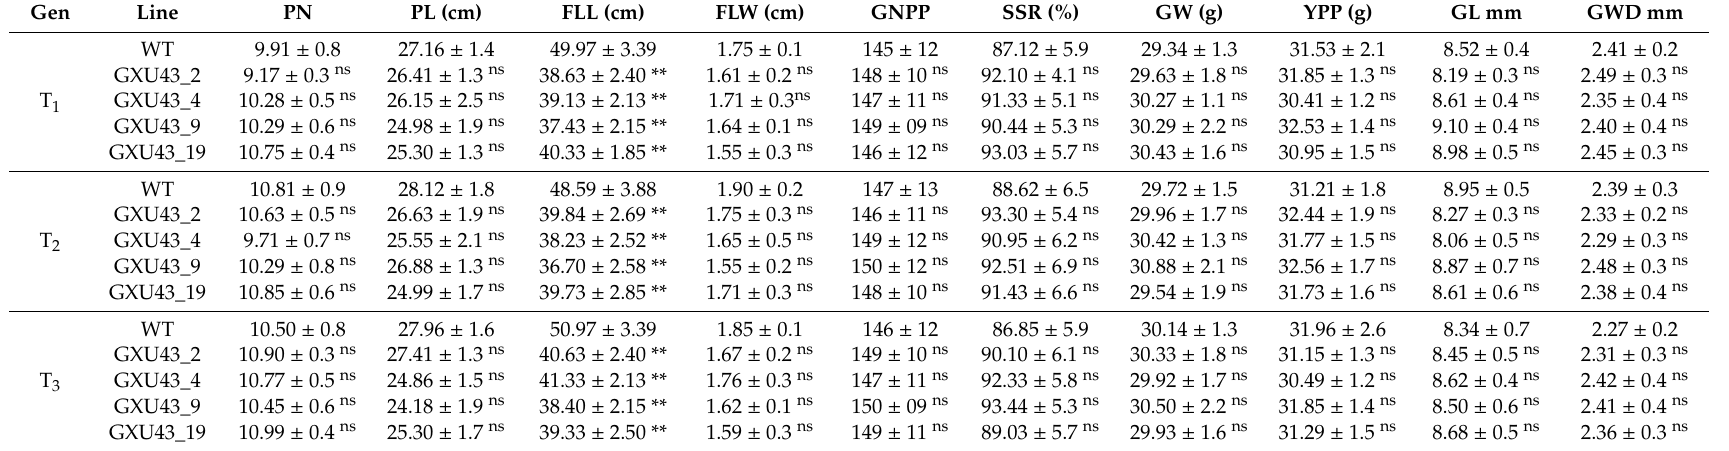
Table 2. Performance of major agronomic traits in WT and mutant